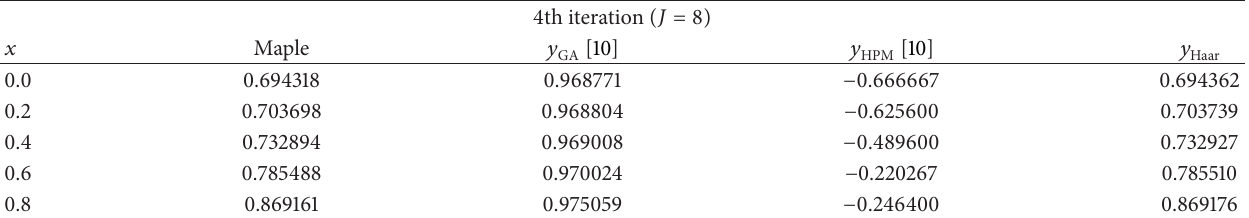
Table 2: Numerical results for temperature distribution equation for 𝜀 = 2.0 : Haar wavelet-quasilinearization technique at 4th iteration and level of resolutions 𝐽 = 8